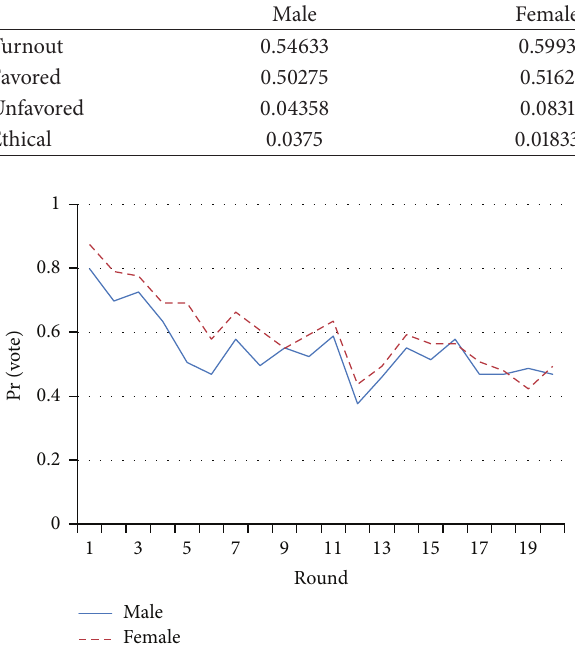
Figure 5: Voting turnout rates by